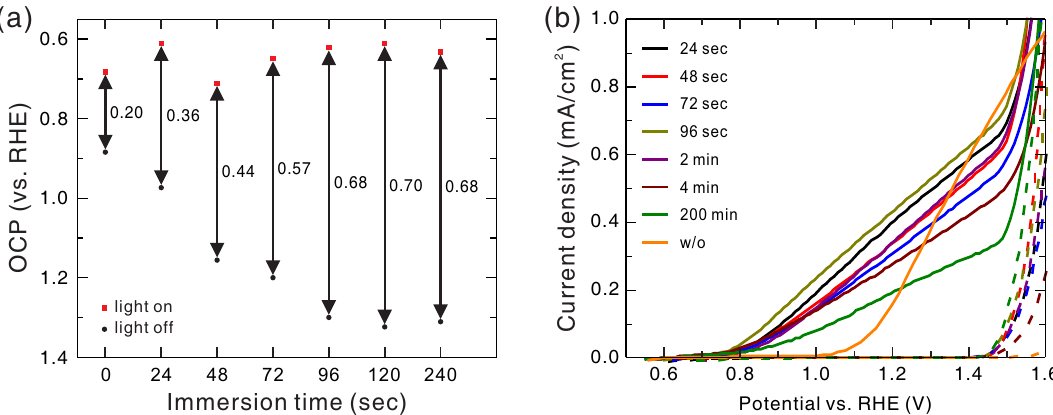
Figure 2. ( a ) open-circuit potentials (OCP) and ( b ) J–V curves of Ni x Fe 1 − x O y /hematite photoanodes grown with various immersion times measured at the light-on and light-off conditions. The Ni-to-Fe ratio of the precursor was